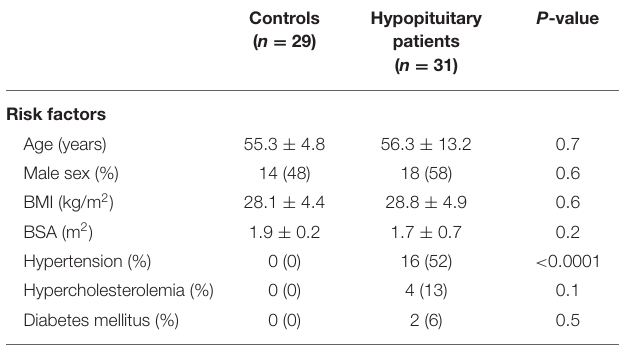
TABLE 1 | Demographic and clinical data of patients with hypopituitarism and controls.